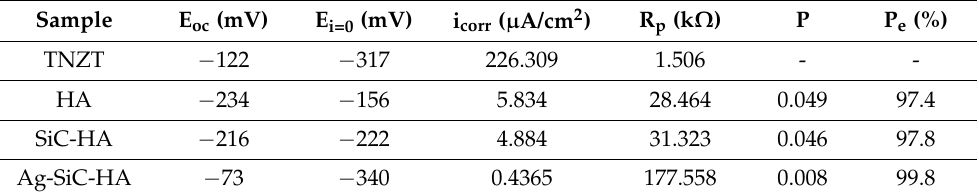
Table 4. The corrosion parameters of the coatings: open circuit potential (E OC ), corrosion potential (E i=0 ), corrosion current density (i corr ), polarization resistance (R p ), porosity (P) and protective efficiency (P e ).